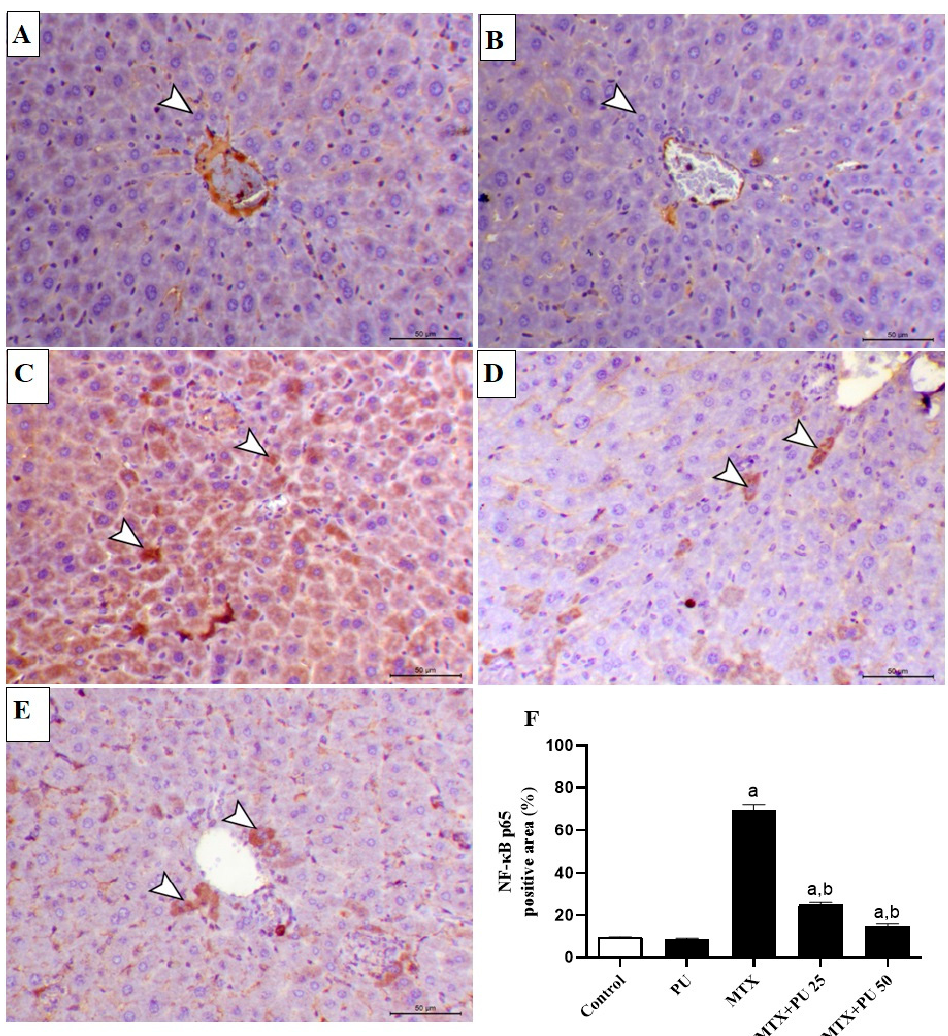
Figure 4. PU attenuates hepatic inflammatory reaction in MTX-administered mice. Photomicro- graphs of microscopic field from liver of ( A ) control and ( B ) PU-treated mice showing minimal immunoexpression of NF- κ B p65 in the hepatic tissues (arrowheads); ( C ) MTX-injected mice demonstrating marked immunoexpression of cytoplasmic and nuclear hepatocytes’ NF- κ B p65 (arrowheads); ( D ) MTX-injected mice pre-treated with 25 mg PU demonstrating decreased hepatocytes’ NF- κ B p65 immunoexpression (arrowheads); and ( E ) MTX-injected animals pre-treated with 50 mg PU demonstrating noticeable decreased hepatocytes’ NF- κ B p65 immunoexpression (arrowheads) (IHC, X200, Scale bar = 50 µm). ( F ) Image analysis of hepatocytes’ NF- κ B p65 immunostaining demonstrating significant rise of NF- κ B p65 in MTX-injected mice and sig- nificant decline of NF- κ B p65 in mice pretreated with both doses of PU before MTX injection. Re- sults are expressed as mean ± SEM, ( n = 6). a indicates significant ( p < 0.05) vs. control, while b in- dicates significant ( p < 0.05) vs. MTX.